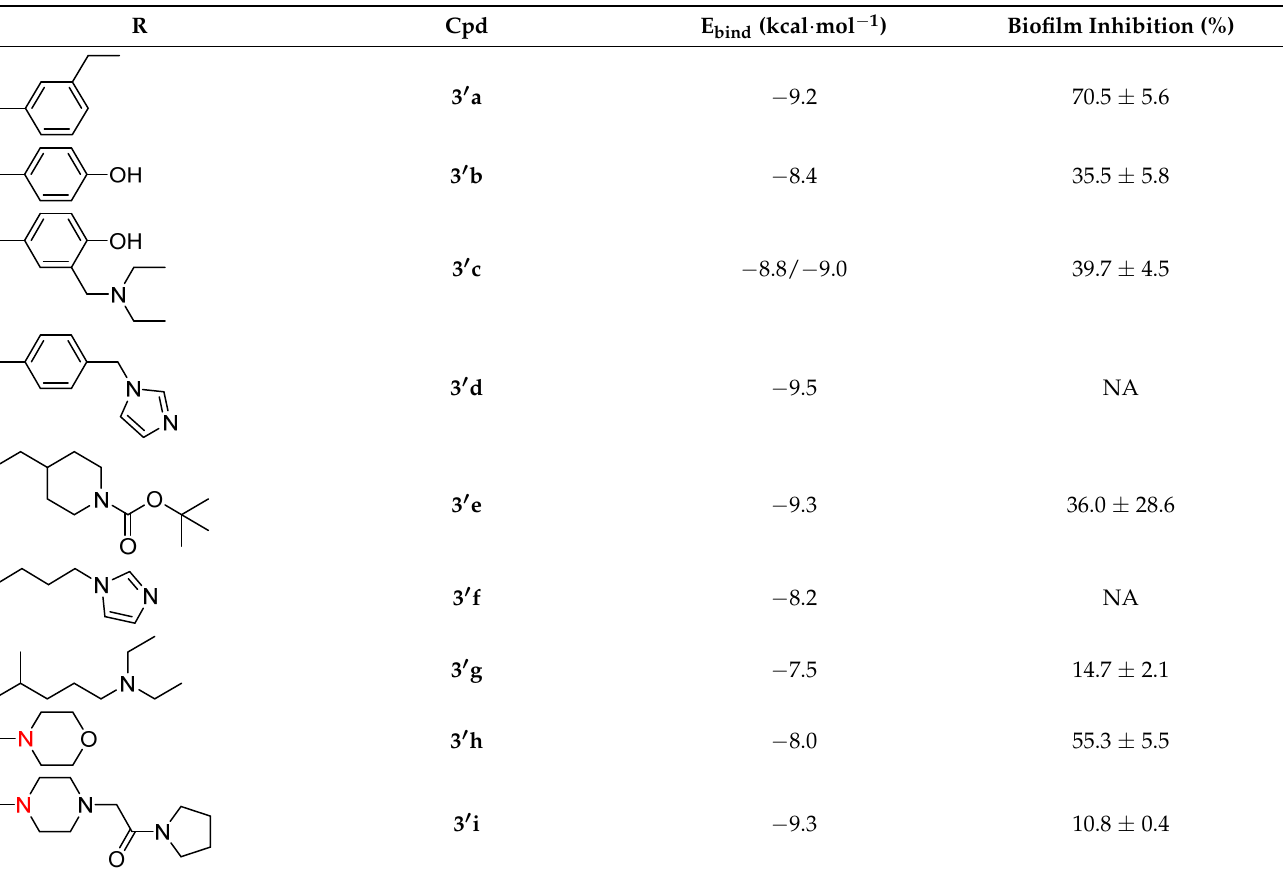
Table 3. Docking scores (E bind , kcal · mol − 1 ) and in vitro anti-biofilm activity data for direct chromone carboxamides ( 3 ′ a-i ). The anti-biofilm activity is expressed in % of inhibition as the mean ± SD of 3 independent experiments (n = 3 * 2). NA: non-active (% inhibition < 10.0%).